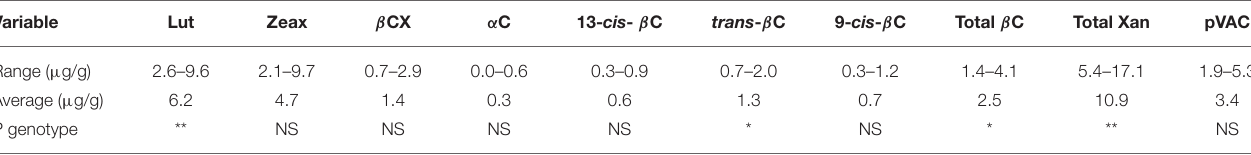
TABLE 1 | Carotenoids profile of Striga -resistant yellow-orange maize hybrids grown at Zaria and Saminaka ( N = 64). Variable Lut